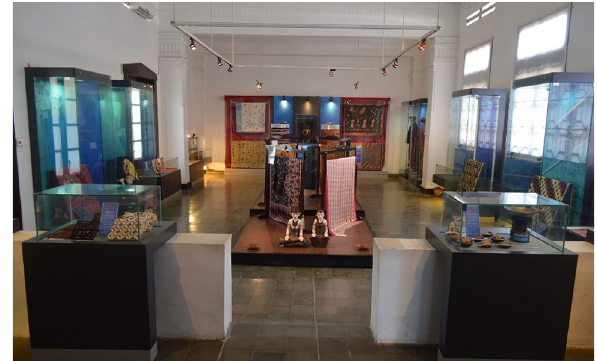
Figure 2. Batik collections in the Batik Museum Pekalongan 33